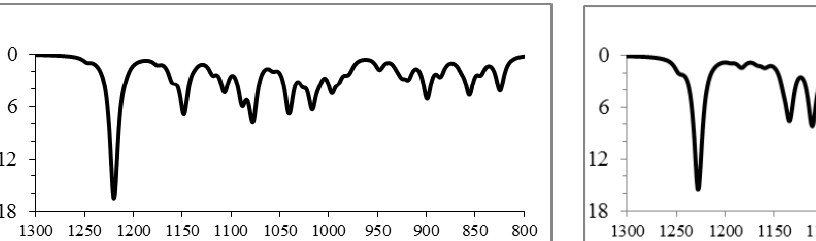
Figure 2. Simulated infrared spectra (fingerprint region) of the four possible diastereomers of